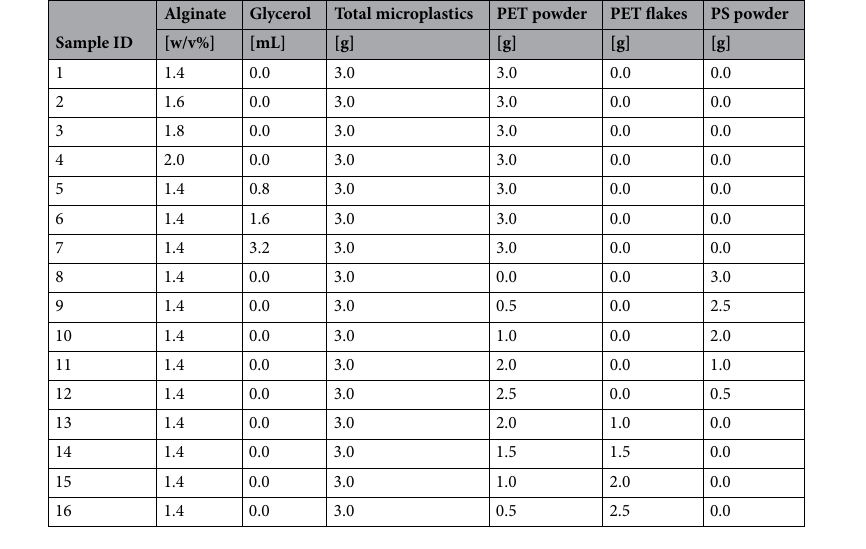
Table 1. Details of the foam samples’